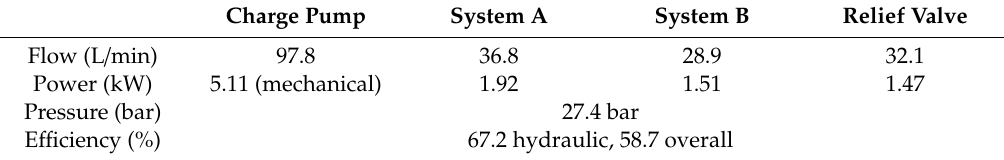
Table 5. Low-pressure results of a standard system for static conditions.